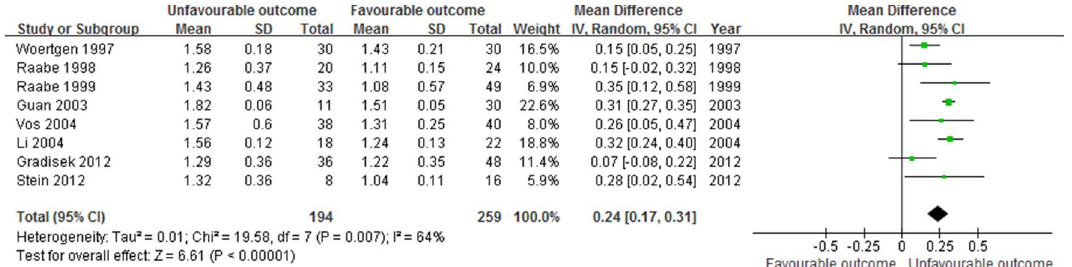
Figure 4. Association between NSE (shown as mean (SD) in transformed concentration) and unfavourable outcome in patients with traumatic brain injury.